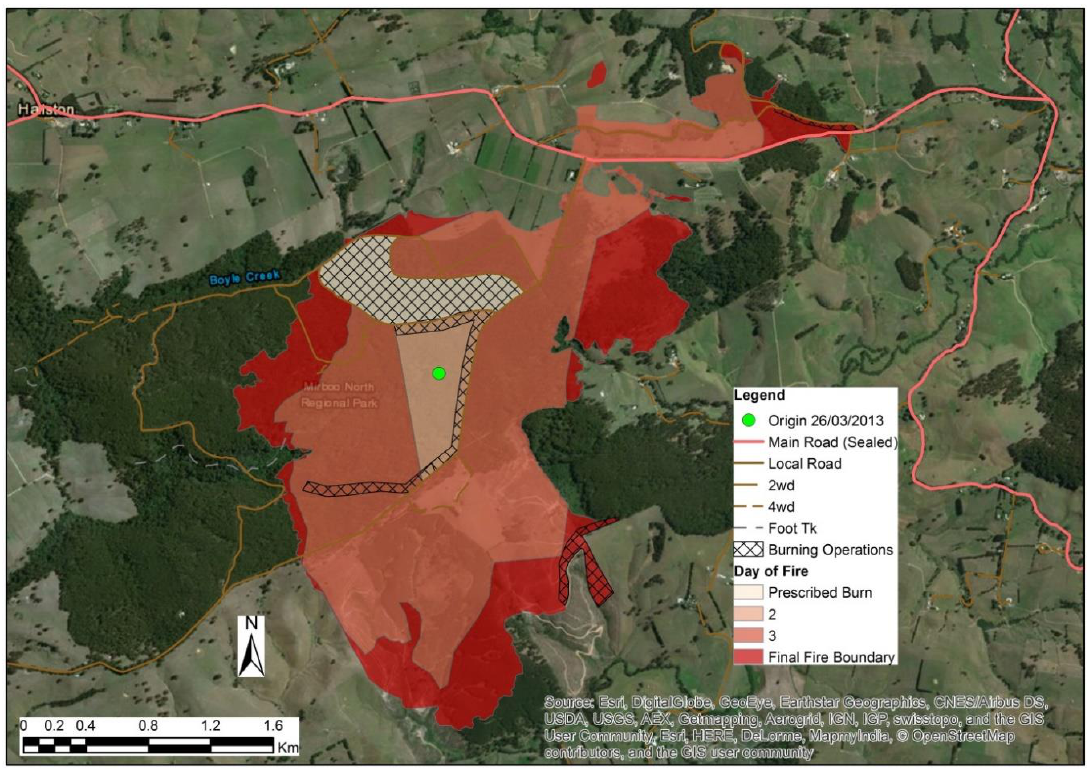
Figure A2. Hallston fire progression map.